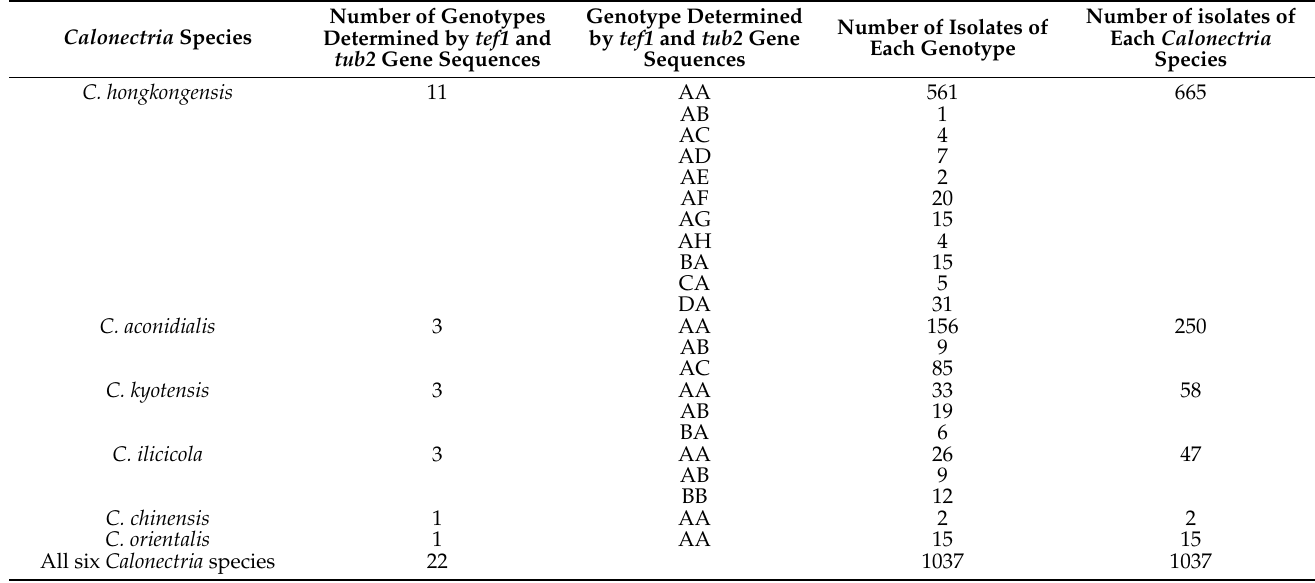
Calonectria Species